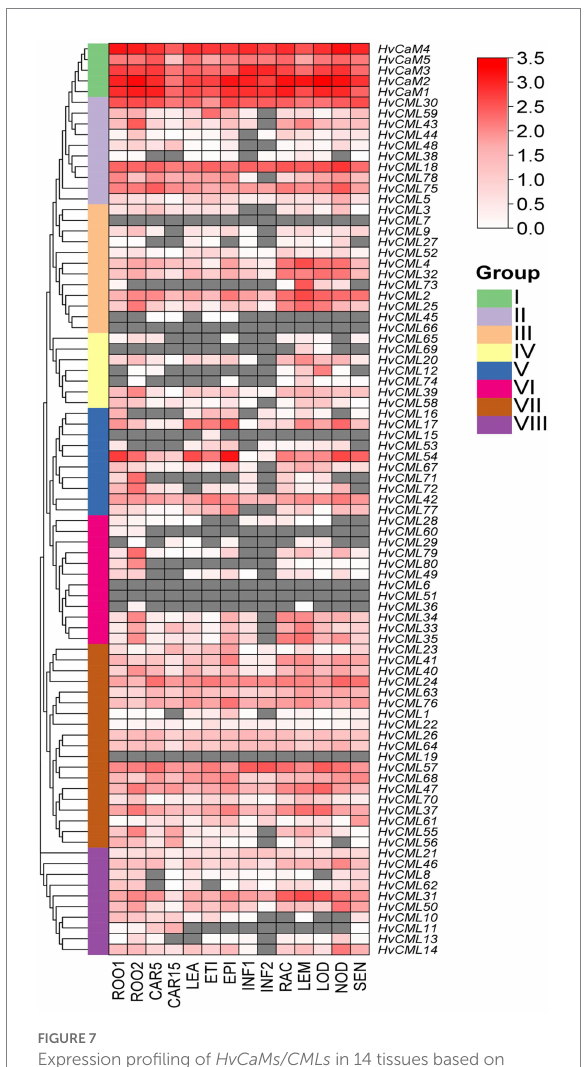
FIGURE 7 Expression profiling of HvCaMs/CMLs in 14 tissues based on transcriptomic data. FPKM values were normalized by log 10 (FPKM+1) transformation. ROO1, roots from seedlings (10 cm shoot stage); ROO2, roots (28 DAP); CAR5, developing grain (5 DAP); CAR15, developing grain (15 DAP); LEA, shoots from seedlings (10 cm shoot stage); ETI, etiolated seedling, dark condition (10 DAP); EPI, epidermal strips (28 DAP); INF1, young developing inflorescences (5 mm); INF2, developing inflorescences (1–1.5 cm); RAC, inflorescences, rachis (35 DAP); LEM, inflorescences, lemma (42 DAP); LOD, inflorescences, lodicule (42 DAP); NOD, developing tillers, 3rd internode (42 DAP); SEN, senescing leaves (56